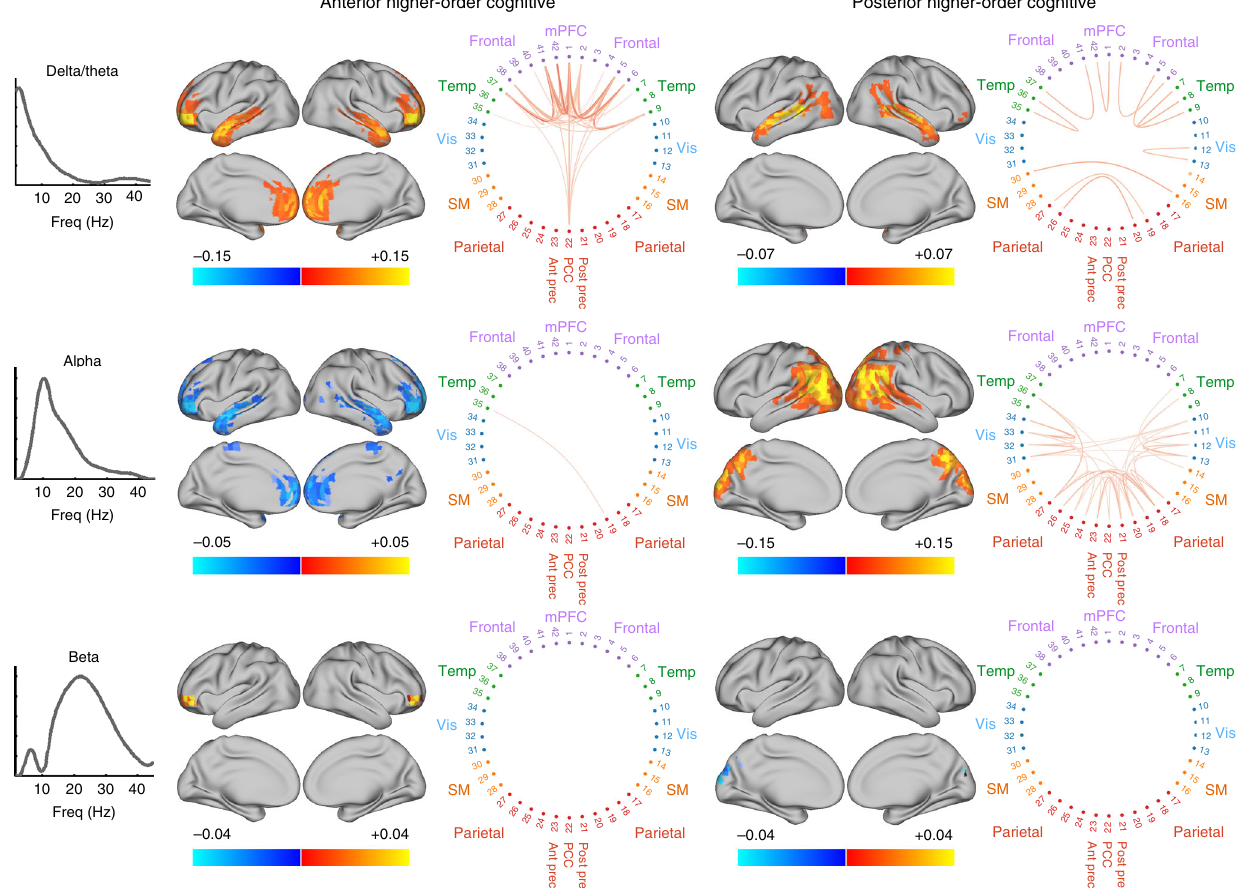
Fig. 4 The two higher-order cognitive states operate in different frequencies. Frequency-speci fi c relative power maps and phase-coupling (see Fig. 2 for details) for the anterior and posterior higher-order cognitive states and for the three data-driven estimated frequency modes. Whereas activity (power and phase-locking) is dominant in the delta/theta frequencies for the anterior-cognitive state, the posterior-cognitive state is dominated by alpha. Both